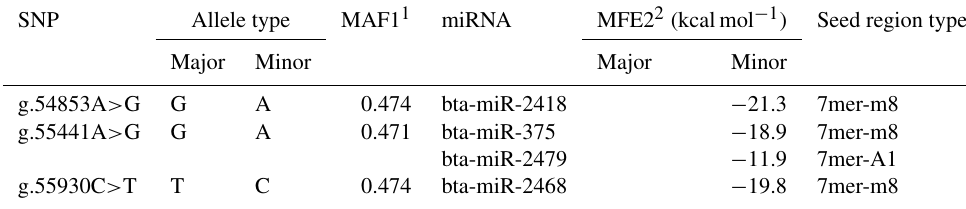
Table 3. Information of miRNAs that bind on candidate functional SNPs in the 3 (cid:48) -UTR of the GPAM gene. SNP Allele type MAF1